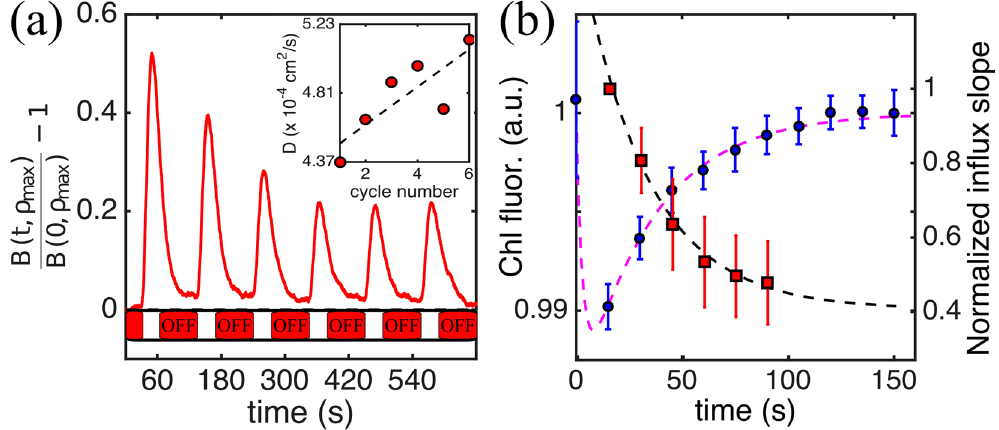
Figure 3. Acclimation of the phototactic response. ( a ) Representative accumulation and dispersal curves at ρ = 958 μ m for six consecutive light on-off cycles. ( b ) Red squares: decay of the normalised phototactic sensitivity β ( t )/ β (0) through the cycles. The time axis includes only periods of light-on. Error bars represent the standard deviation of the whole set of 60 measurements. Black dashed line: exponential fit, giving an acclimation timescale of τ β = 31.84 ± 1.94 s. Blue circles: evolution of the normalised chlorophyll fluorescence Φ Φ chl ( t )/ chl (0) for CC2905 cells subjected to the same light on-off protocol. Error bars are the standard deviation of the whole set of 46 repeats, each including ~1500 cells on average. Magenta dashed line: fit to a two-timescale process. The initial fast response and the ensuing long acclimation are characterised respectively by the timescales τ = . ± . 1 47 0 21 f s and τ = . ± . 33 49 5 2 s chl chl